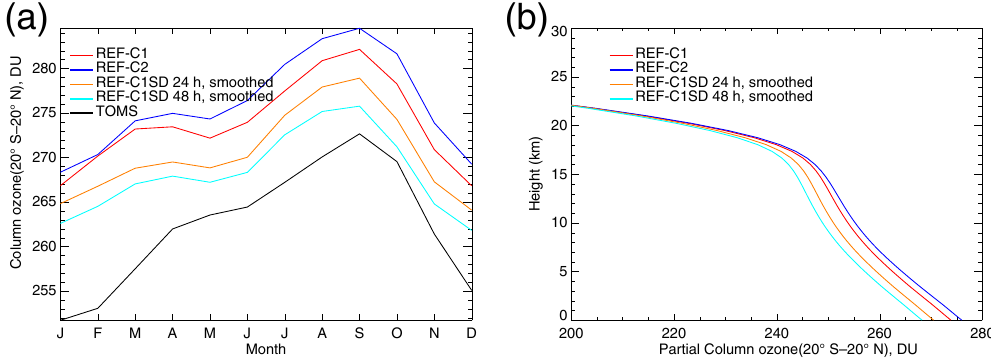
Figure 17. (a) Seasonal cycle in tropical TCO, averaged over the years 1980–1999, as compared to TOMS satellite data. Tick marks indicate the middle of each month. (b) Vertical profile of partial column ozone, integrated downwards from the top of the